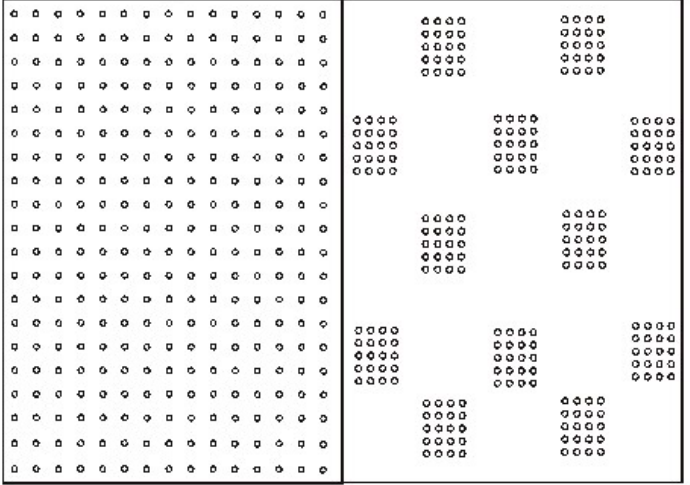
Figure 8. The sods positioning design: on the left, regular, and on the right, with cores.